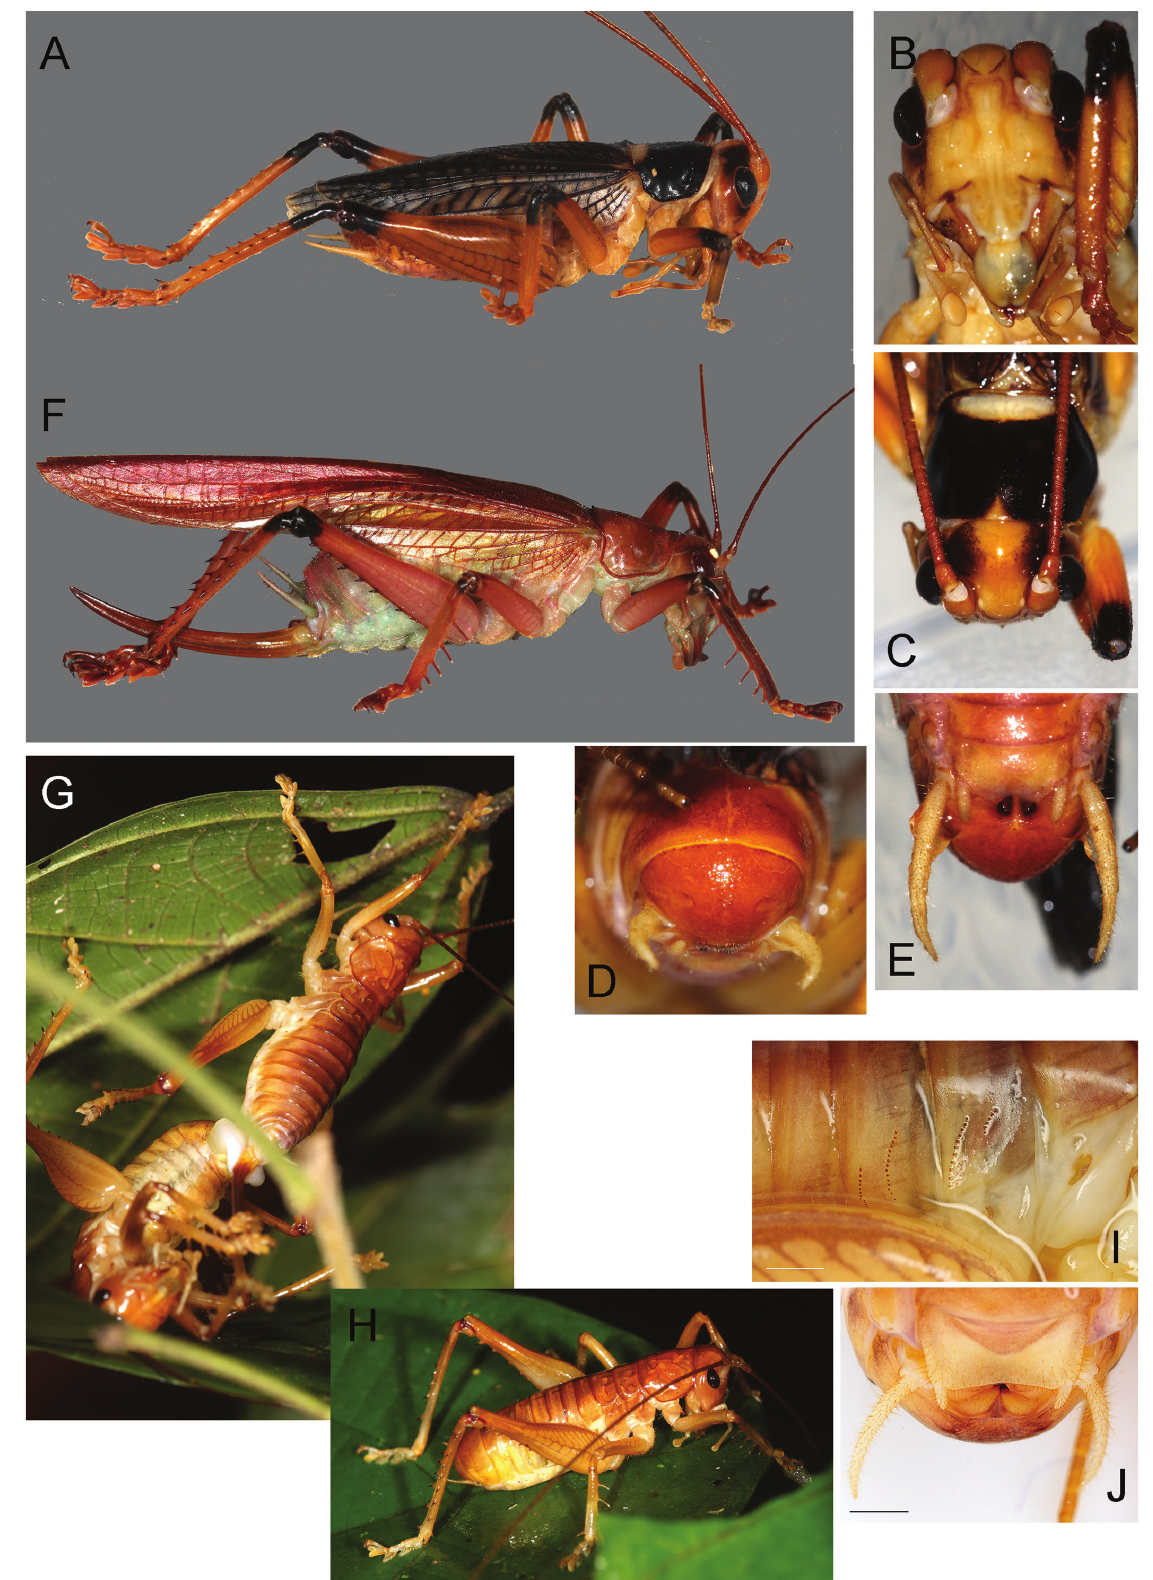
Fig. 13. Gryllacrididae: A. Asarcogryllacris ( Pseudolarnaca ) cf. genualis male; B. Face; C. Dorsal view of head and pronotum; D, E. Abdominal apex; F. Capnogryllacris ( Capnogryllacris ) cf. superba ; G. Melaneremus (?) sp. mating pair; H. Male adult; I. Male stridulatory file; J. Male subgenital plate. Scale bars: